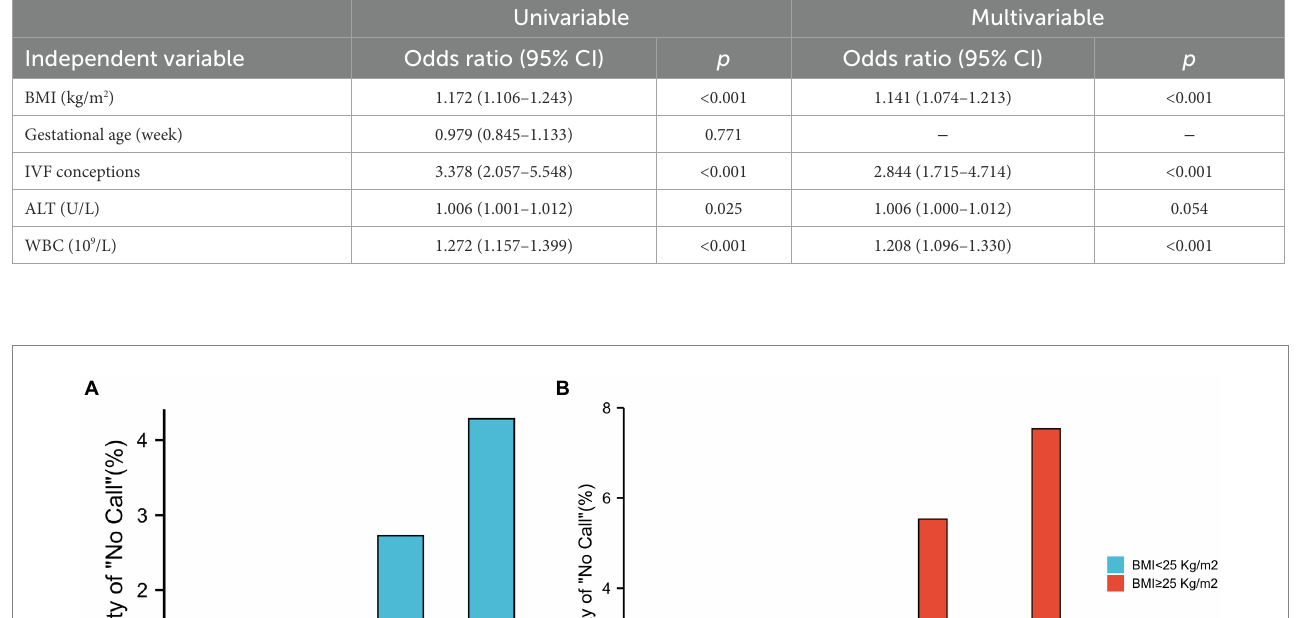
TABLE 3 Logistic regression analysis factors that contribute to the test failure rate Univariable